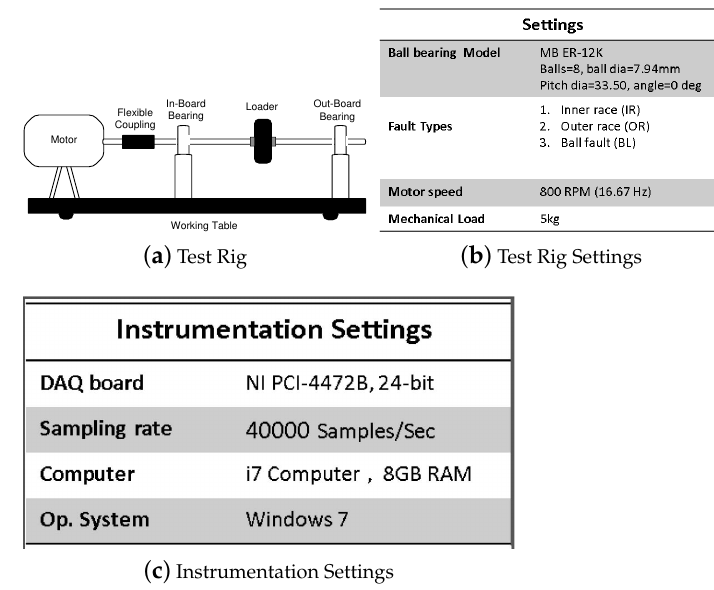
Figure 2. Test rig block diagram and